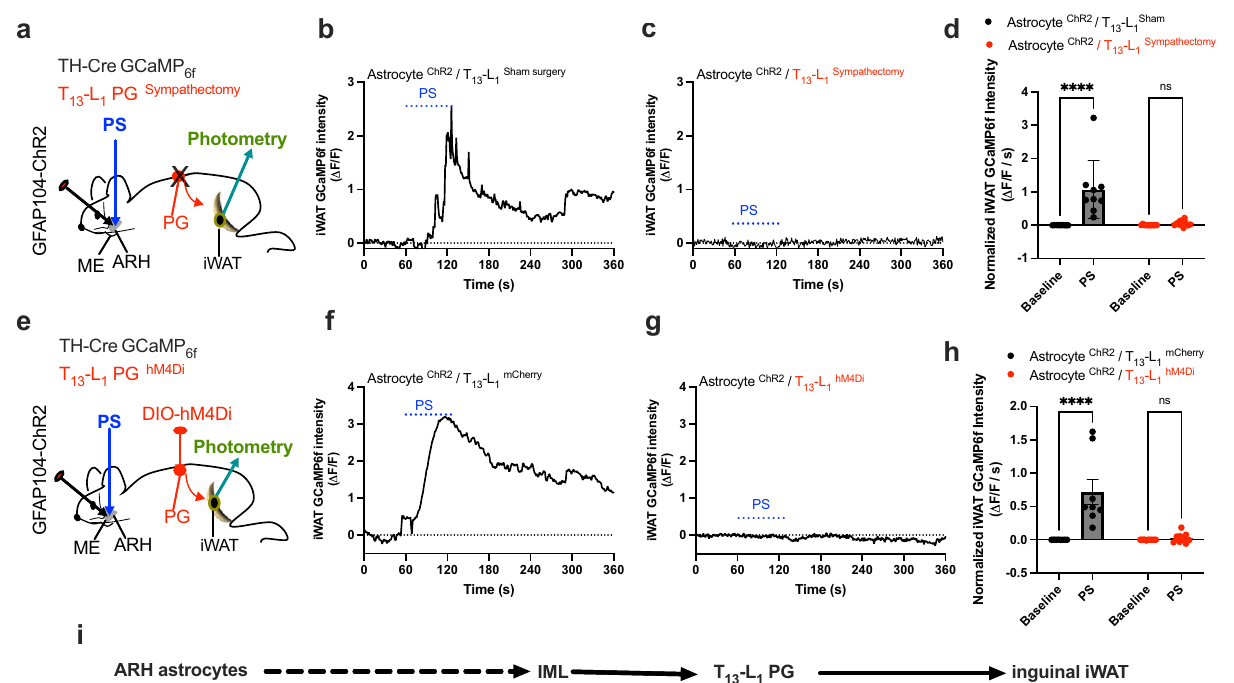
Fig. 5 | T 13 -L 1 PG sympathectomy or inhibition blunts astrocyte promoting the sympatheticdrivetoiWAT.a Schematicillustrationoftargetingavectorcarrying GFAP104-dependentChR2to the ARHand implanting anoptic fi ber over ARH,and placing a photometry fi ber in inguinal iWAT in T 13 -L 1 PG sympathectomy dual TH- Cre GCaMP 6f mice. b – d PG sympathectomy blunts astrocyte stimulation-induced excitationofiWATsympatheticinputs: b , c Representativephotometrymonitoring of TH-positivenerveGCaMP 6f signalswithPSof ChR2-transduced astrocytesinthe PG b Sham- and c sympathectomy mice respectively, and d Group data of average GCaMP 6f signalsfrom b and c ( n =9pergroup). e Schematicillustrationoftargeting a vector carrying Cre-dependent hM4Di to T 13 -L 1 PG in astrocyte ChR2-transduced andARH-implanteddualTH-CreGCaMP 6f mice. f - h :InhibitionofthePGwithJ60via